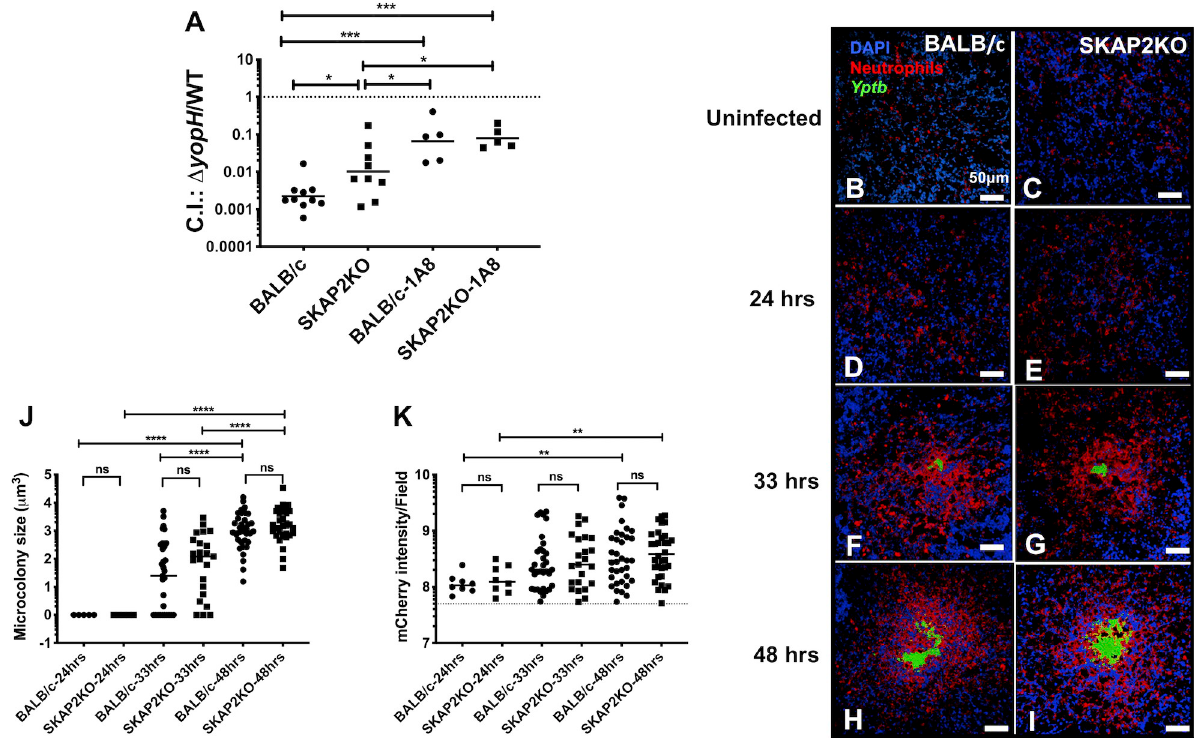
Fig 2. Skap2KO neutrophils cluster to Yptb microcolonies and the growth of a Δ yopH mutant is partially restored in competition with WT- Yptb in Skap2KO mice. (A) WT-BALB/c and Skap2KO mice were injected with 1A8 or an isotype control antibody and 16 hrs later I.V. infected with an equal mixture of 1x10 3 CFU of IP2666 WT- Yptb and Δ yopH- Kan R . Spleens were collected three days post-infection, weighed, homogenized, and plated for CFU on selective and non-selective agar. The number of bacteria recovered from selective and non-selective plates was used to determine the C.I. Each dot represents a mouse; horizontal bars represent the geometric mean. Significance was calculated using 2-way ANOVA followed by Tukey’s Post-test of log 10 transformed values, with only significant values shown. The results are a composite of three experiments. (B-I) BALB/c and Skap2KO mice were (B-C) uninfected or (D-I) I.V. infected with 10 3 CFU of IP2666 WT- Yptb -GFP (green), and sacrificed at (D-E) 24, (F-G) 33, or (H-I) 48 hours post-infection. Frozen sections of spleens were stained using an anti-Ly6G antibody (neutrophils-red) and DAPI (nuclei-blue) and visualized by fluorescence confocal microscopy at 40X magnification. (J-K) Using Volocity software, the size of the (J) bacterial microcolony was determined by generating the summed volume of the individual GFP signal and the (K) number of neutrophils recruited was determined by detecting the signal intensity of the mCherry channel. Each dot represents a microcolony or an area of clustered neutrophils. The horizontal solid bars represent the median, and (K) the dotted line represents the median neutrophil signal intensity in uninfected controls of BALB/c and Skap2KO mice. Scale bars: 50 μ m. Statistical significance was determined (J-K) using Mann-Whitney for comparing BALB/c and Skap2KO at each time point and Kruskal-Wallis for comparisons between the three time points for each mouse genotype. The results are a composite of 2–3 mice from two independent experiments.